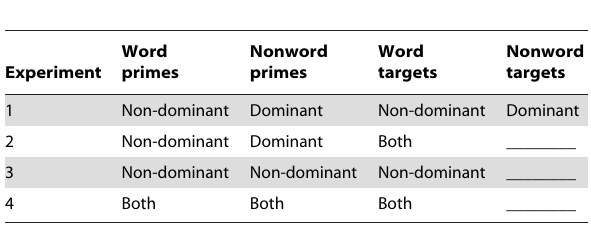
Table 2. Type of stress pattern used in each condition of the